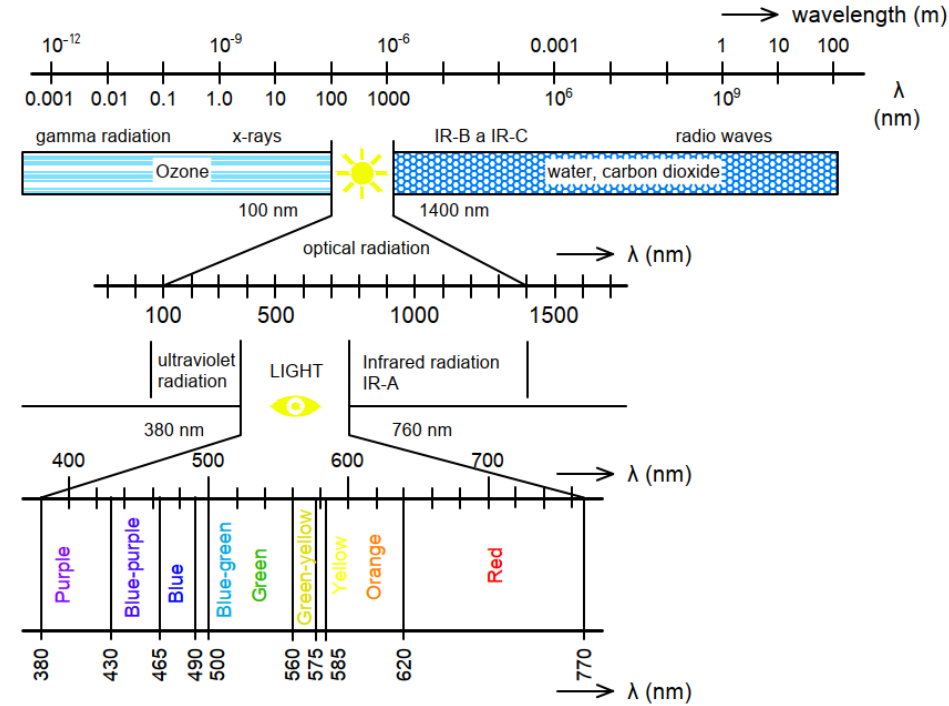
Figure 1. Electromagnetic